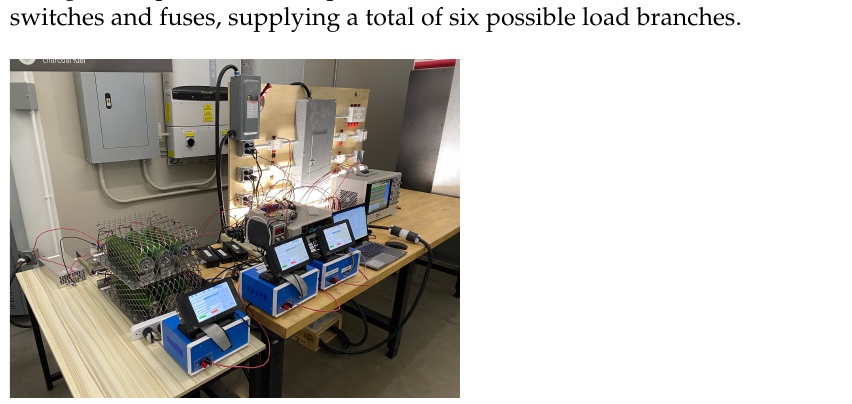
Figure 16. Testbed hardware with power analyzer, laptop, LEDs and resistive load banks. (Photo used with permission by Arthur Santos of Colorado State